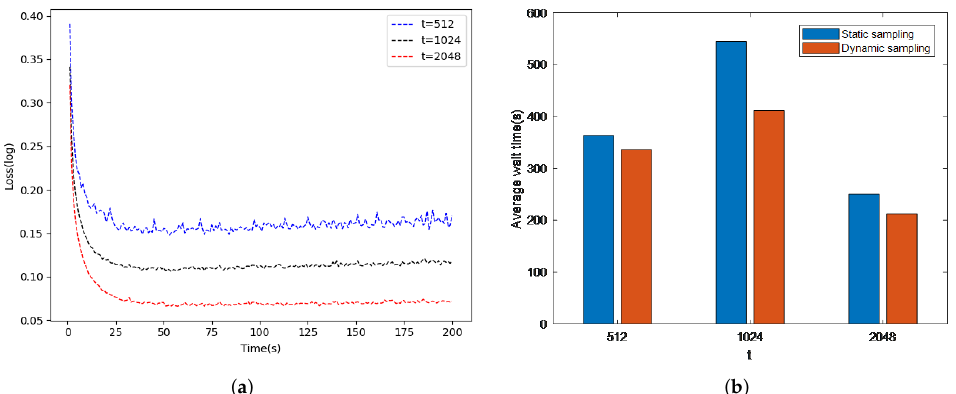
Figure 3. DisSAGD convergence and waiting time during iteration (( a ) is DisSAGD convergence and ( b ) is waiting time during